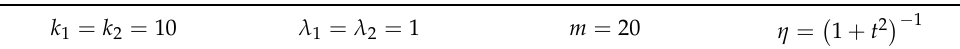
Table 3. Design parameters.